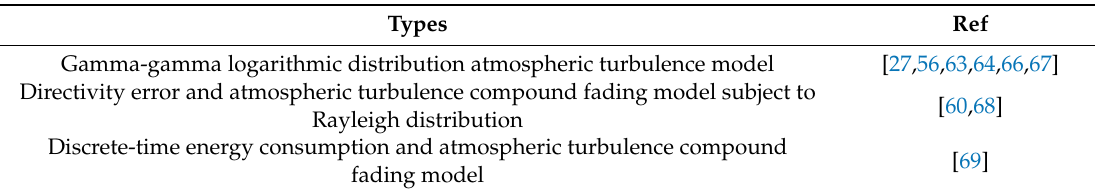
Table 3. Air-to-air (A2A) experimental channel